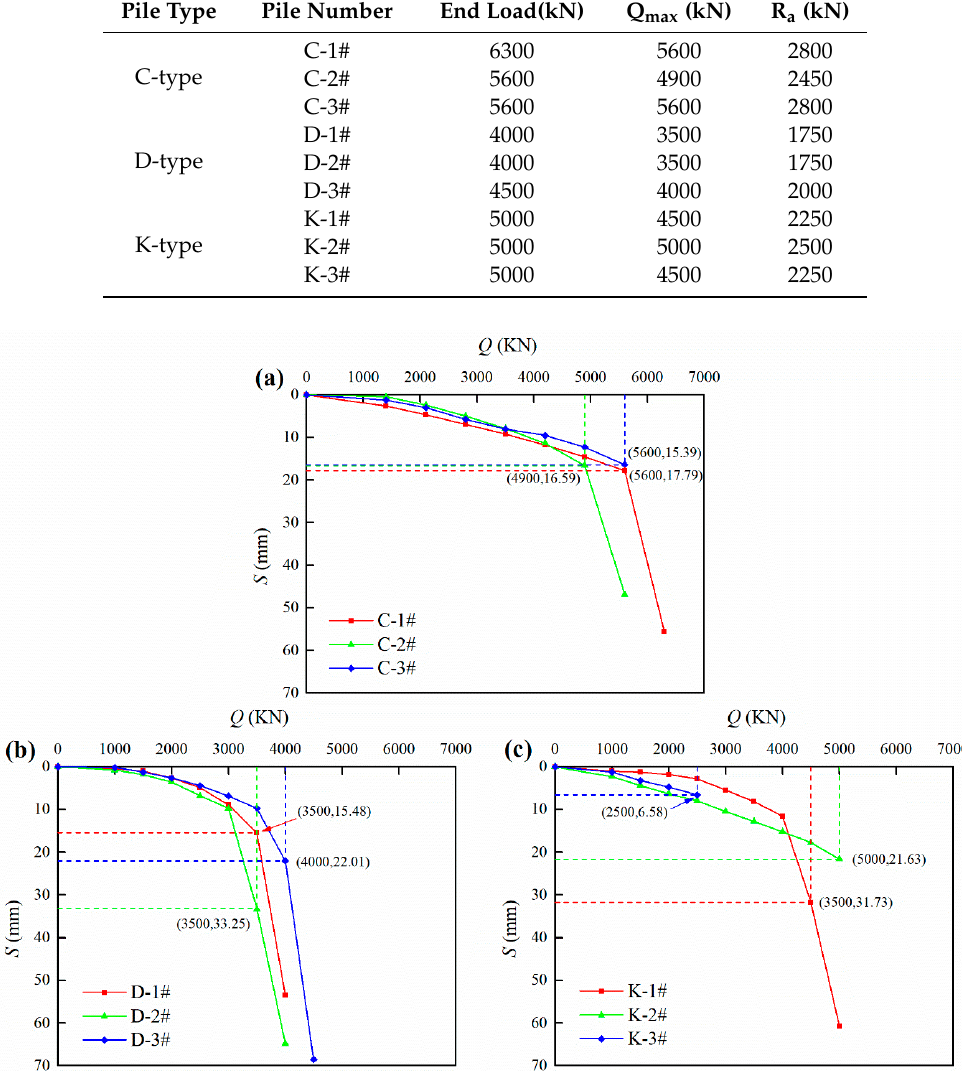
Figure 10. Curves of PHC pipe piles ( a ) C-type; ( b ) D-type; ( c ) K-type.